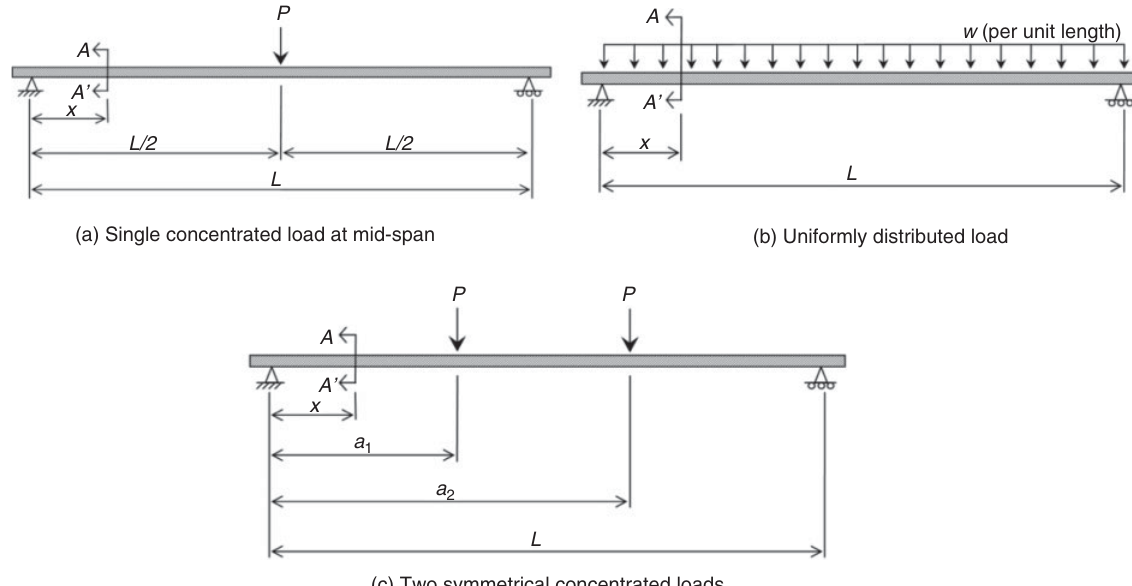
Fig. 3. Load de fi nitions: (a) single concentrated load at mid-span; (b) uniformly distributed load; (c) two symmetrical concentrated